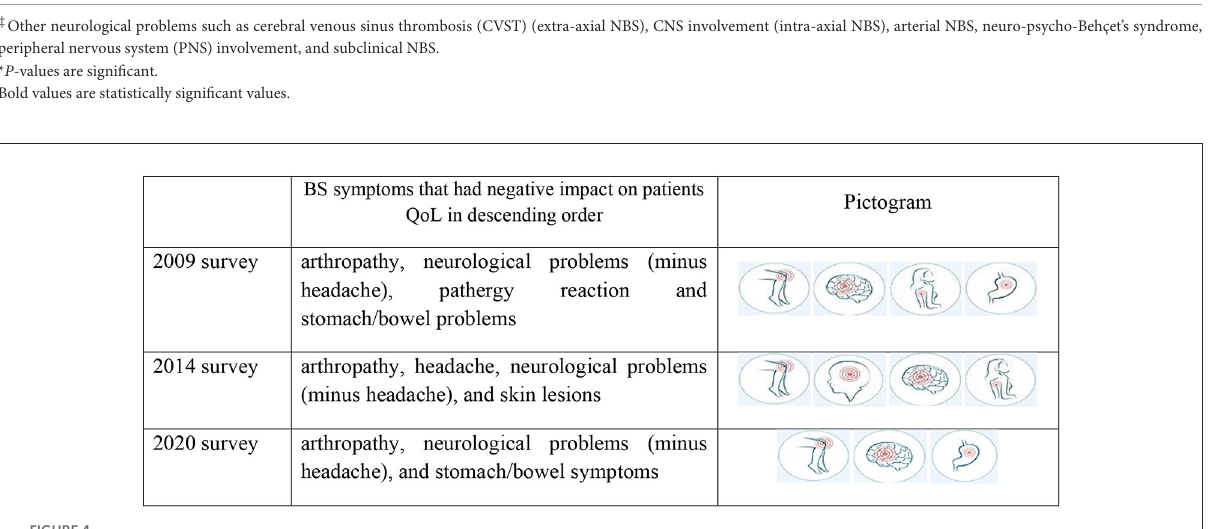
(Table 2). In 2014 survey were; arthropathy, headache, neurological features, pathergy reaction, and skin lesions